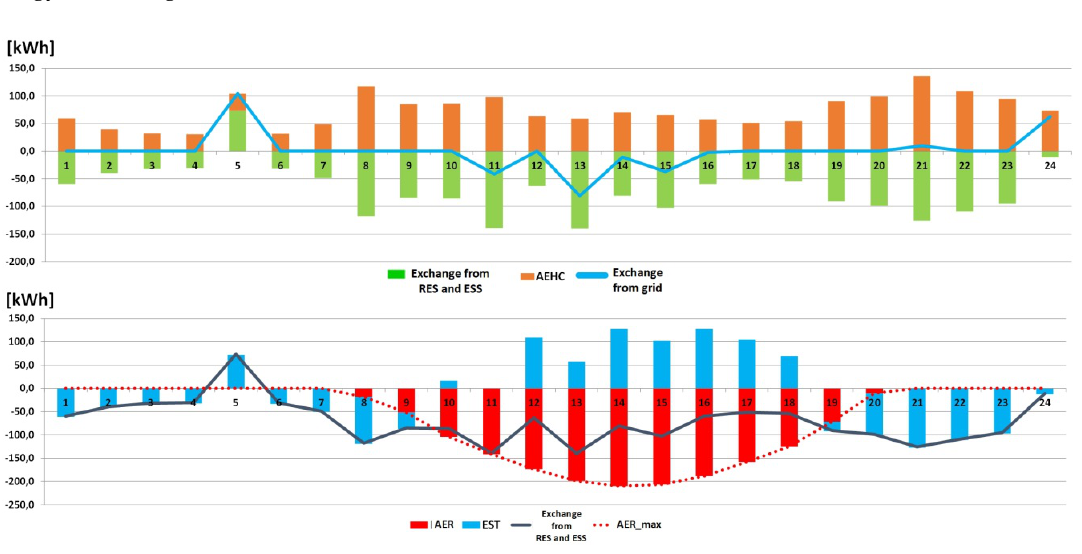
Figure 12. Energy management during the simulation day under the hourly net metering scheme, with an ESS configuration.